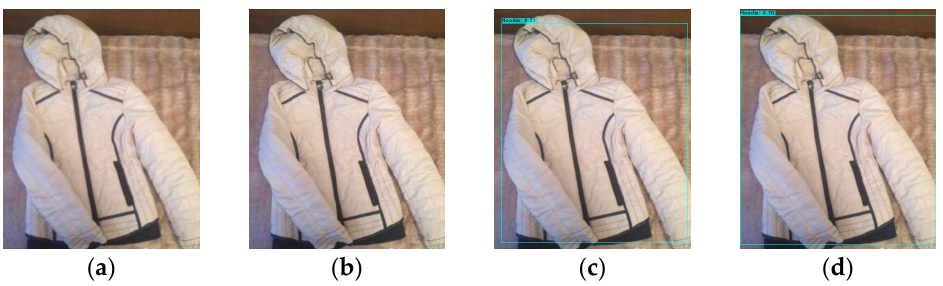
( d ) Figure 11. Detection results of before and after pseudo-labeling. ( a ) Dress Detection Result Before Pseudolabeling; ( b ) Dress Detection Result After Pseudolabeling; ( c ) Hoodie Detection Result Be- fore Pseudolabeling; ( d ) Hoodie Detection Result After Pseudolabeling. 4.2. Comparison of Different Augmentation Effects on the Performance of FC-YOLOv4 We also investigate the effect of various image augmentation on detection outcomes. Our investigation utilized three distinct augmentations: Brightening, Mosaic, and CLAHE. We assess the influence of image enhancement on FC-YOLOv4 findings using four distinct datasets: Dataset B, Dataset C, Dataset D, and Dataset E. Figure 12a depicts the detection results following Dataset B training. Figure 12b illustrates the detection out- comes following training with Dataset C. Figure 12c depicts the detection results follow- ing Dataset D training. Figure 12d depicts the detection results following Dataset E train- ing. The precision-recall curves for our model with different augmentation effects are de-